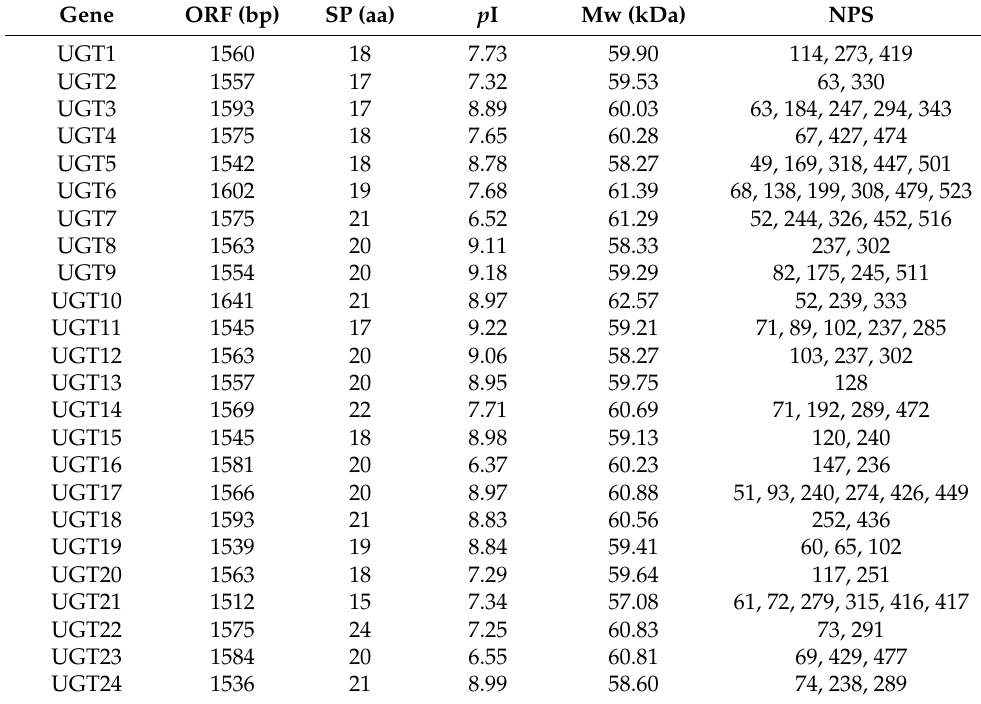
Table 1. Information for 31 full-length UGT genes in A. yunnanensis